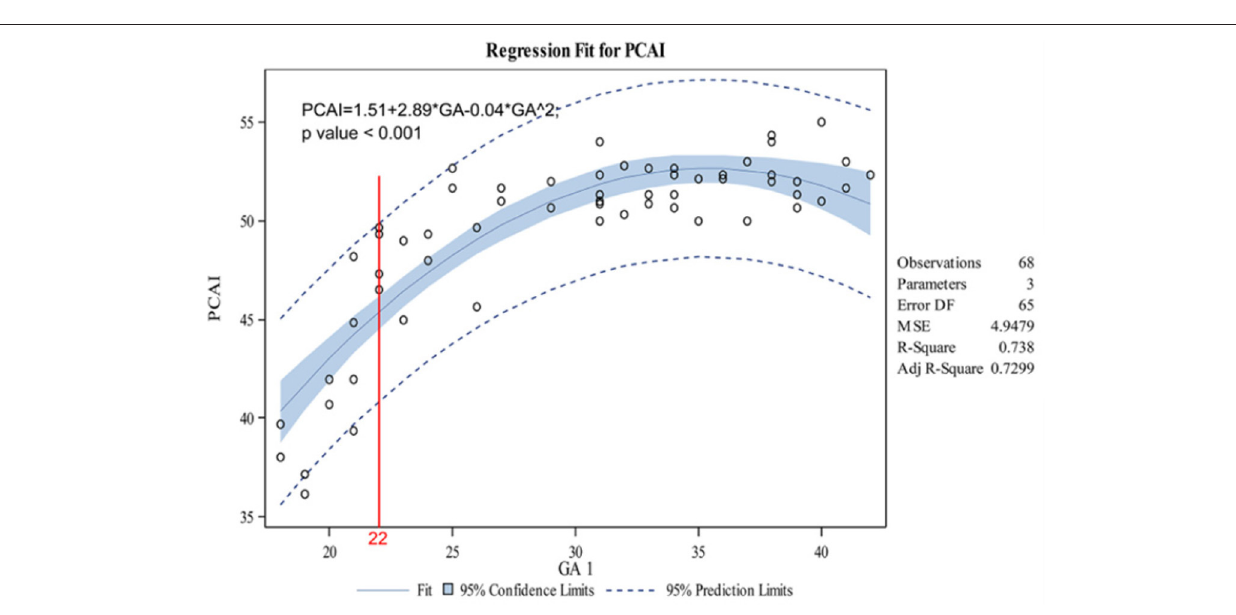
FIGURE 9 | Correlation between gestational age and posterior cartilaginous acetabular